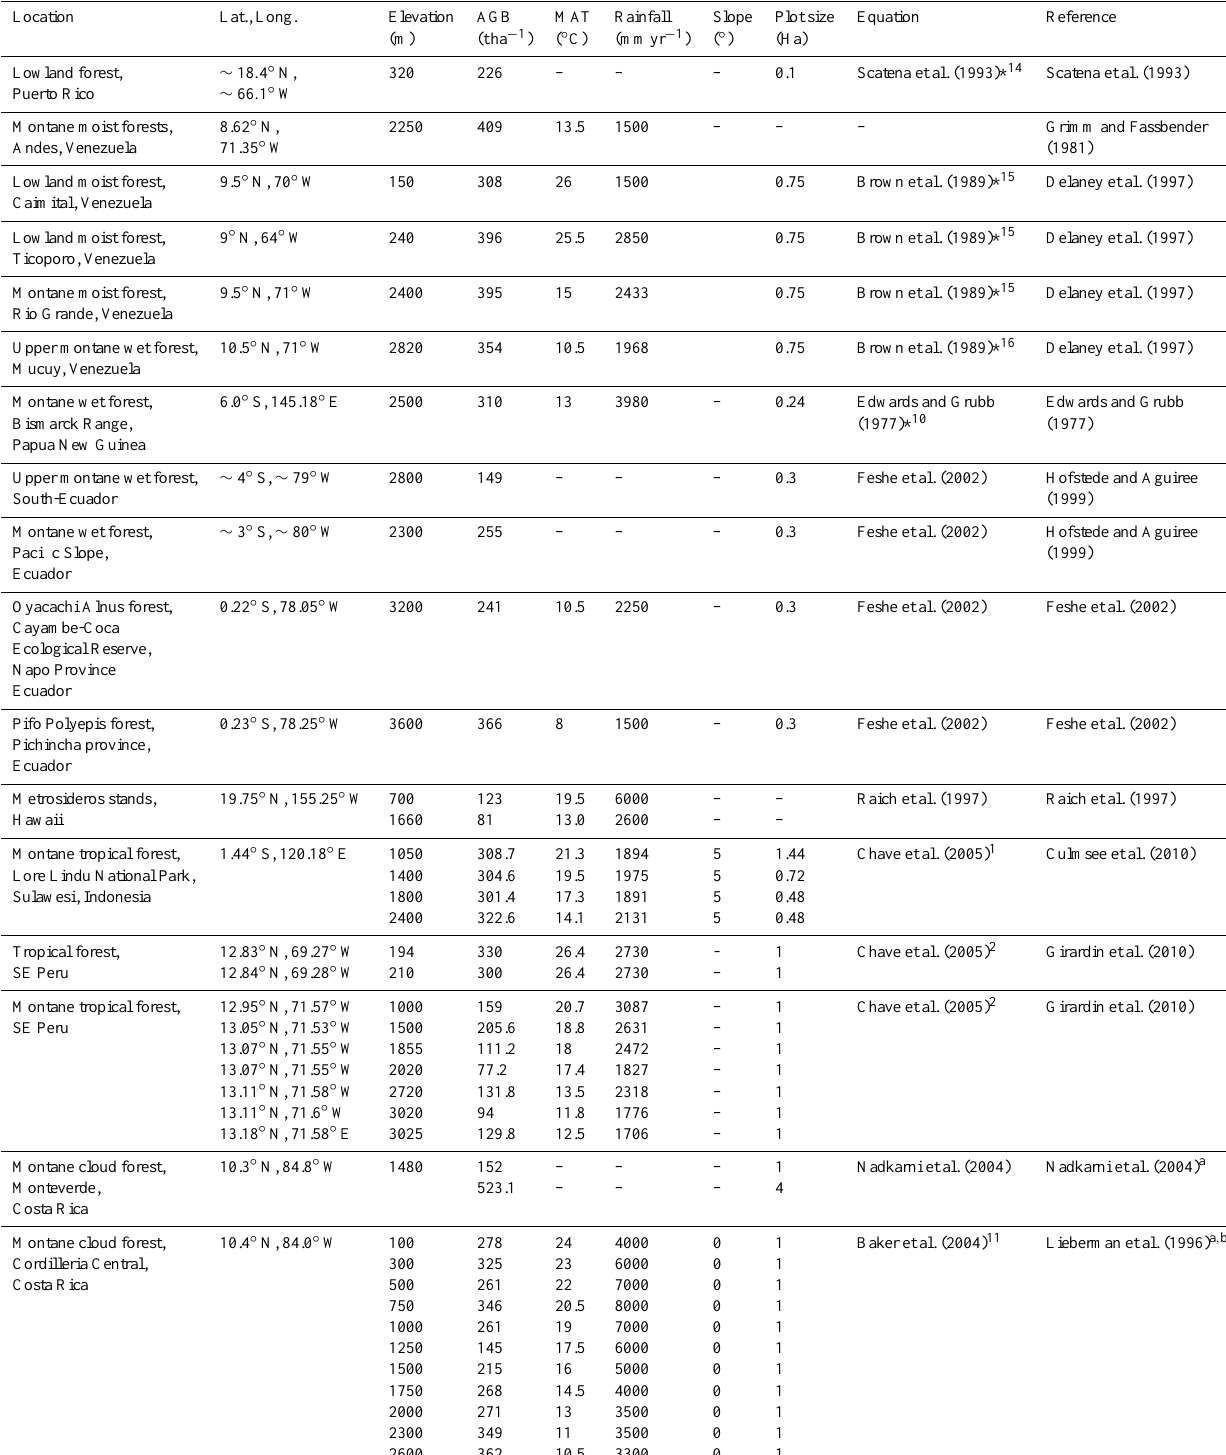
Table 1. Synthesis from the literature of above-ground biomass (AGB) measurements in tropical montane forests (elevation ≥ 1000ma . s . l . ). All AGB values are reported on a land surface basis. Where the studies synthesized here include data on lowland forests (eleva- tion < 1000ma . s . l . ), we include these data in the table below (with the exception of Slik et al. (2010) where we only include data for forests ≥ 1000ma . s . l .